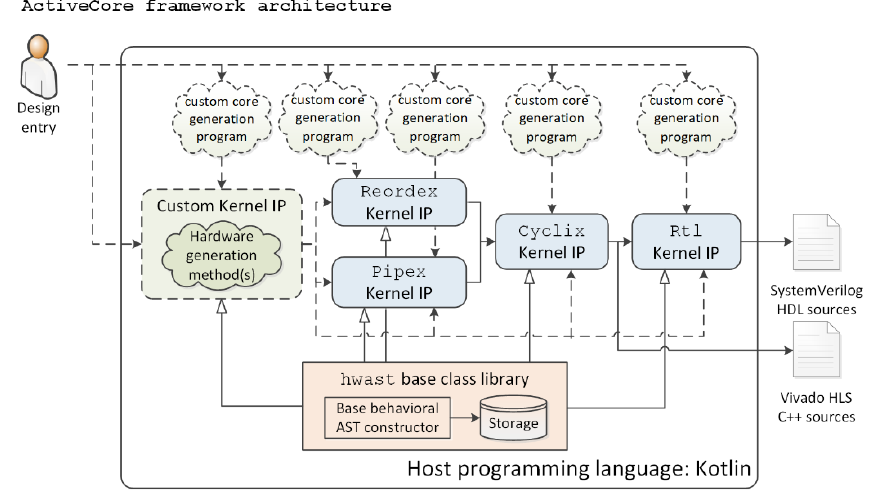
Figure 2. ActiveCore framework architecture.